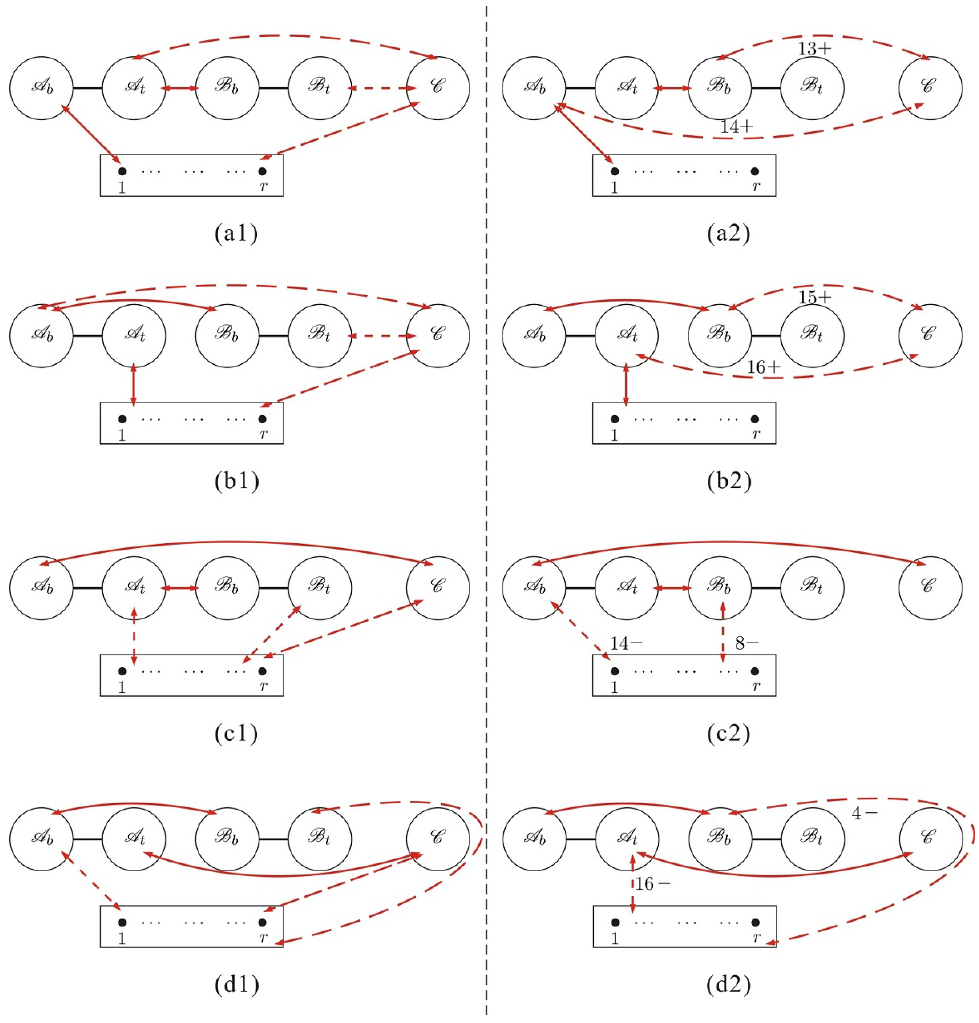
Figure 31 . Physical graphs (a1), (b1), (c1), (d1) for the skeleton (cid:12)gure 11 by construction-2 and the corresponding spurious graphs (a2), (b2), (c2), (d2): part